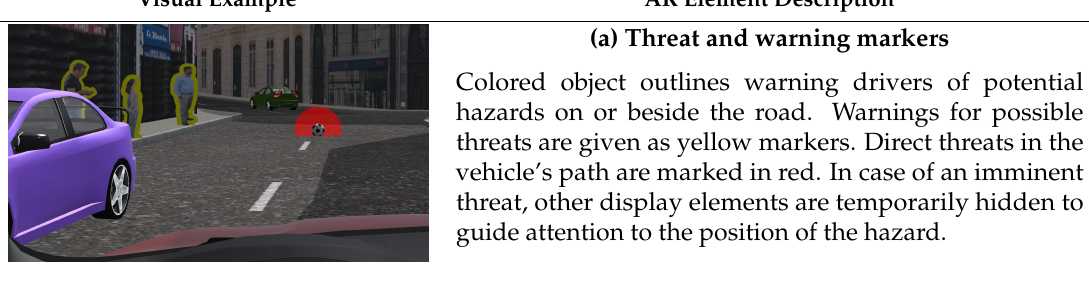
(b) Oncoming traffic indicators Superimposed on the road when the automated car approaches an intersection. Red arrows indicate from where oncoming traffic is detected. Their current distance is roughly indicated by the amount of arrowheads (up